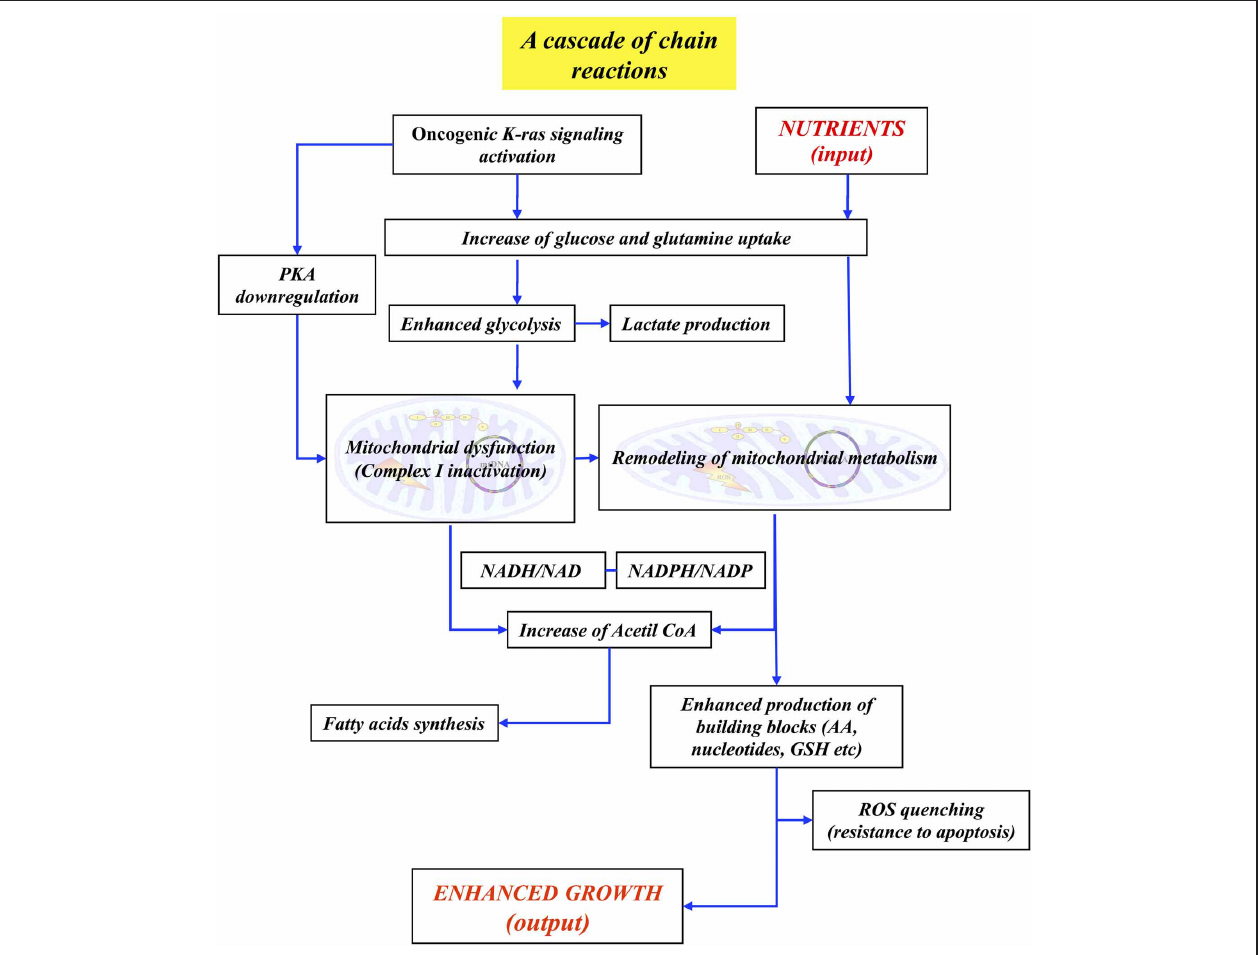
FIGURE 3 | Low resolution concept map of the “enhanced growth” property in cancer cells. The major events—and their interconnections—leading to the enhanced growth phenotype are presented. See the text for